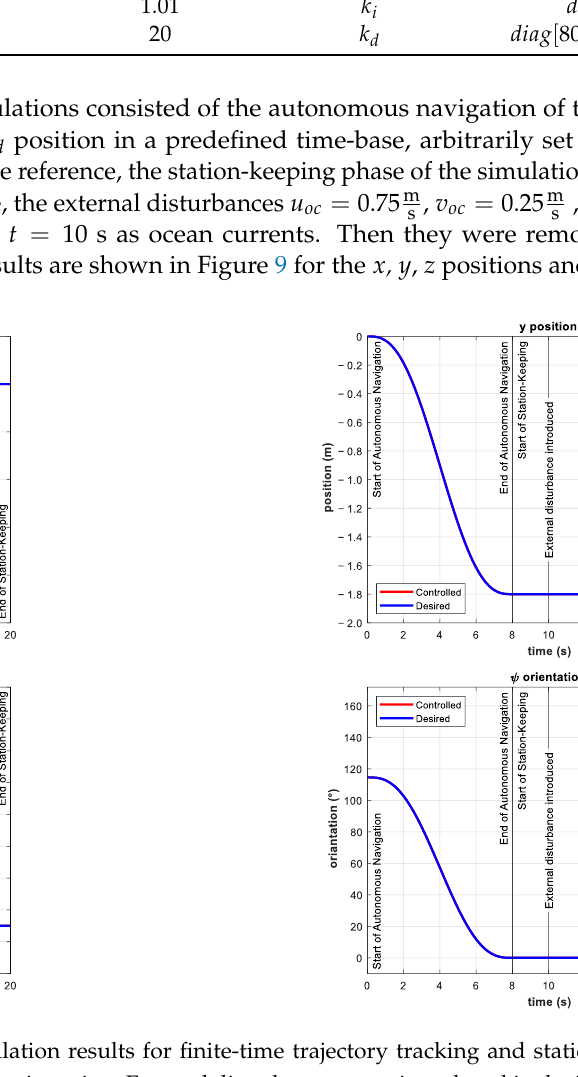
Table 2. Controller parameter set.